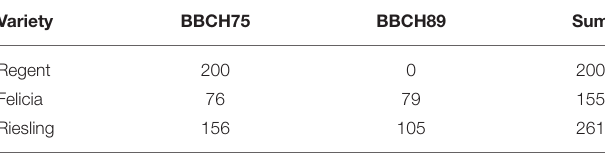
TABLE 1 | Overview of images showing healthy plants.